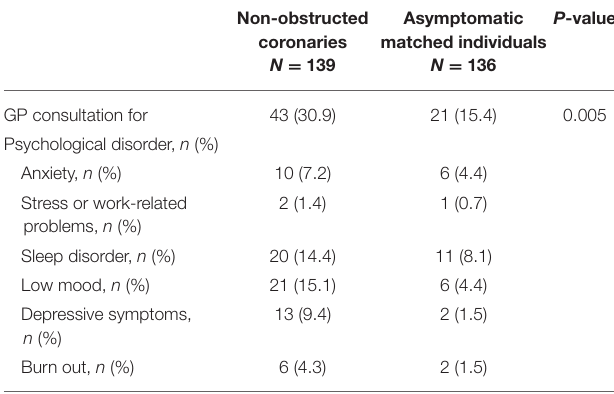
TABLE 3 | Psychological consultations in women and men with non-obstructed coronary arteries vs. asymptomatic matched